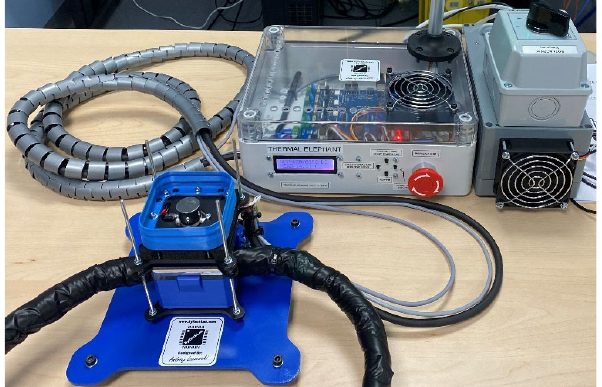
Figure 12. Photo of the Thermal Elephant Unit for scientific radiation imaging systems testing at AGH University of Science and Technology.